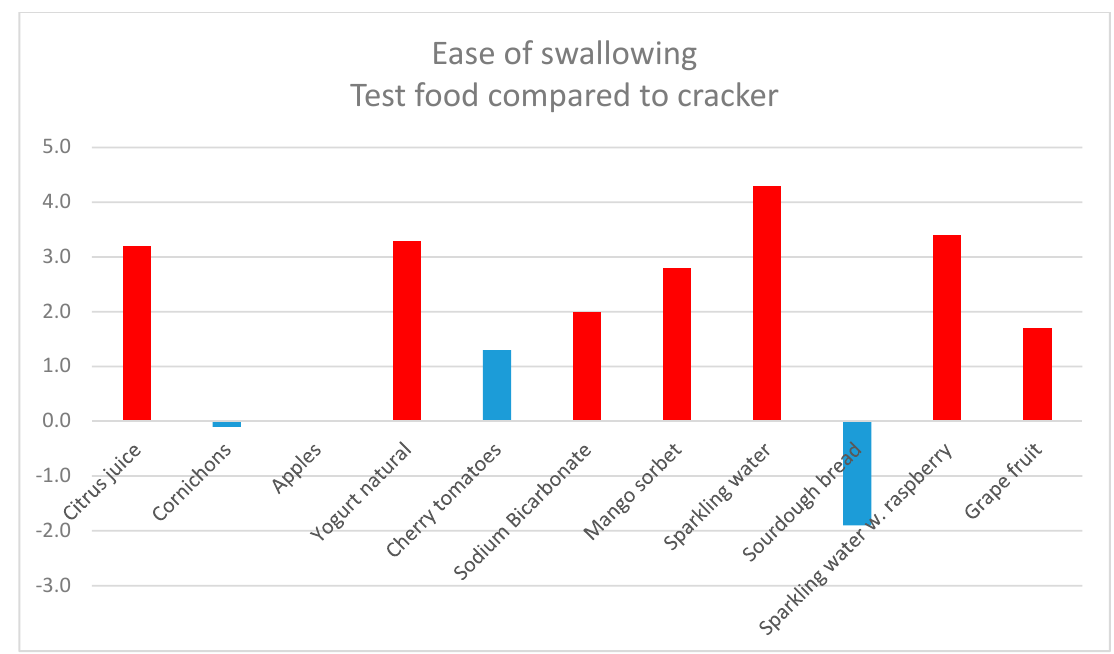
Figure 2. Ease of swallowing test foods compared to the baseline cracker. The red bars indicate a significant difference from the baseline, p ≤ 0.05.